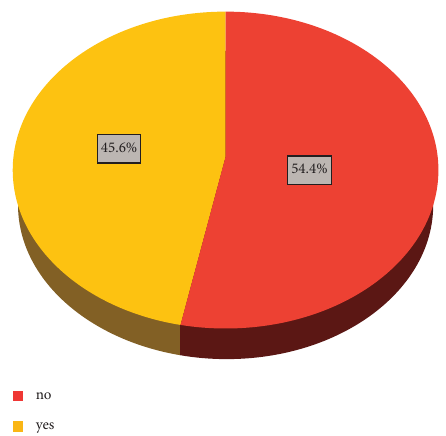
Figure 1: Is there medico-legal obligation to use X-ray before